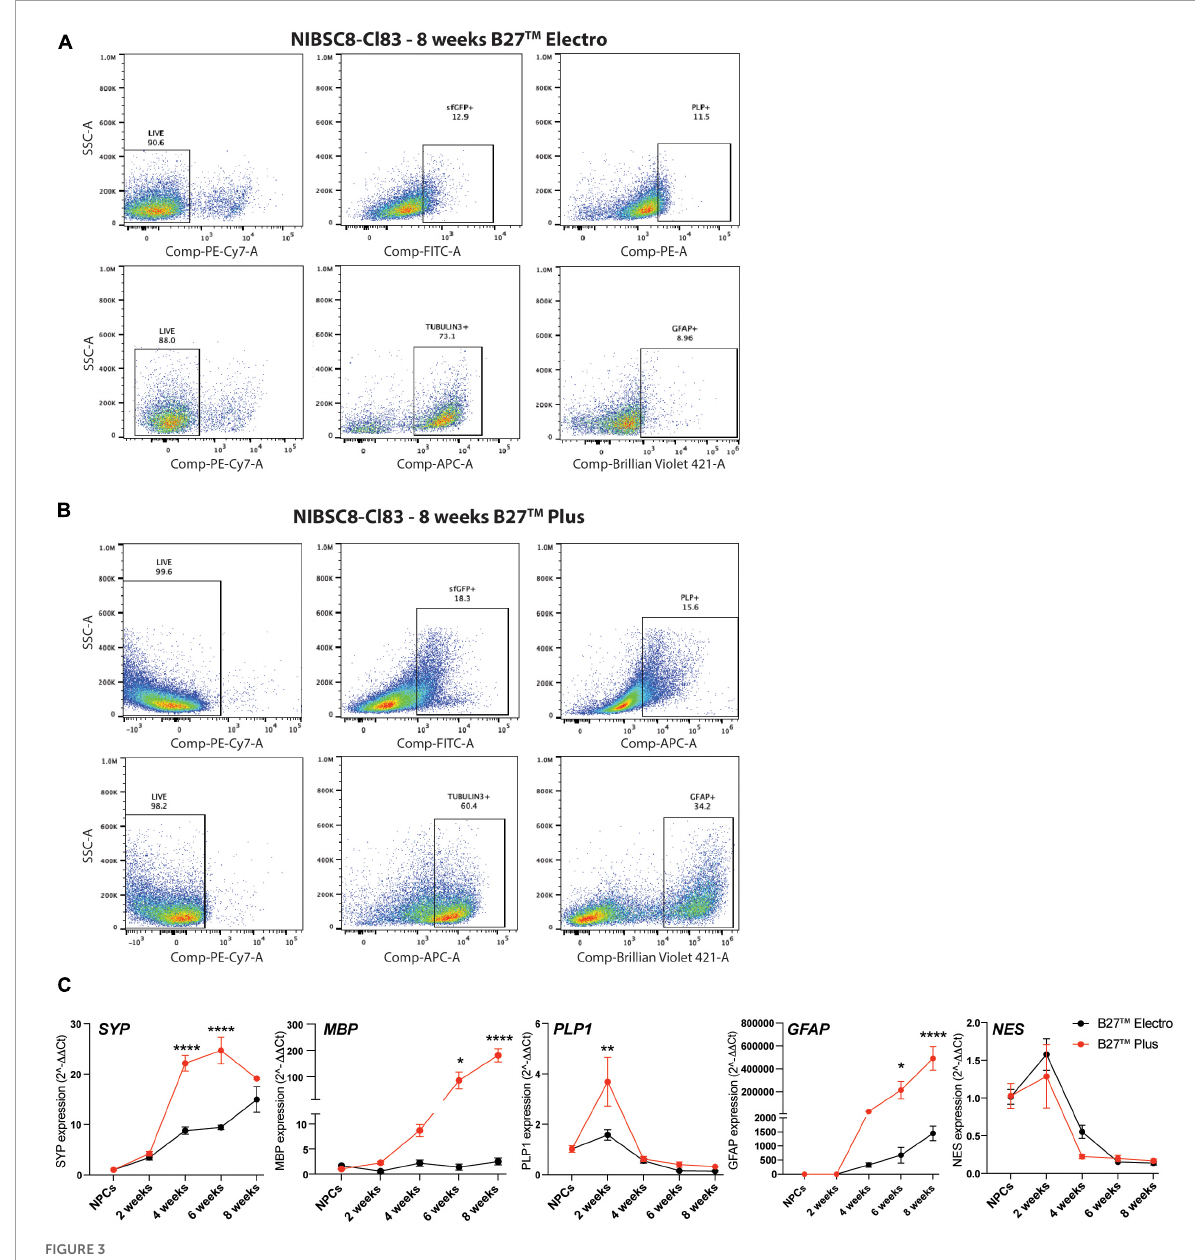
FIGURE3 Optimization of neural differentiation. Representative flow cytometry charts showing sfGFP+, PLP+ and GFAP+ cells in 8-week-old NIBSC8-Cl83 bMPS cultured in B27 TM Electro (A) and B27 TM Plus media (B) . Gates for both conditions were set up based on corresponding single color/unstained controls separately for each condition ( Supplementary Figures 7E, F ). (C) Gene expression of neural markers in NIBSC8-Cl83 bMPS generated using B27 TM Electro vs. B27 TM Plus media. Statistical significance was calculated using two-way ANOVA with Šidák’s multiple comparison test. Data are represented as mean ± SEM from two independent experiments with 2–3 technical replicates. * p < 0.05, ** p < 0.005, **** p < 0.0001. SSC, side scatter; SYP, synaptophysin; MBP, myelin basic protein; PLP1, proteolipid protein 1; GFAP, Glial Fibrillary Acidic Protein; NES,